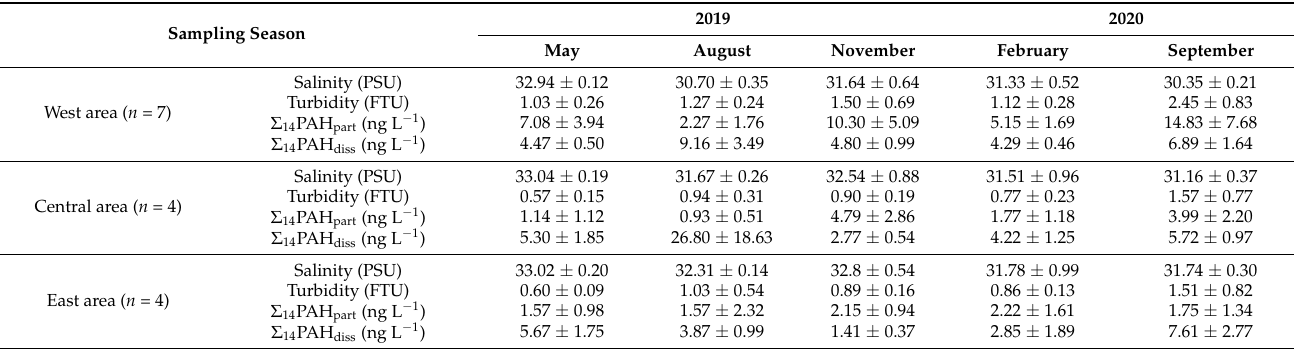
Table 1. Salinity, turbidity, and particulate ( Σ 14 PAH part ) and dissolved ( Σ 14 PAH diss ) PAH averages a at each subarea, for each sampling